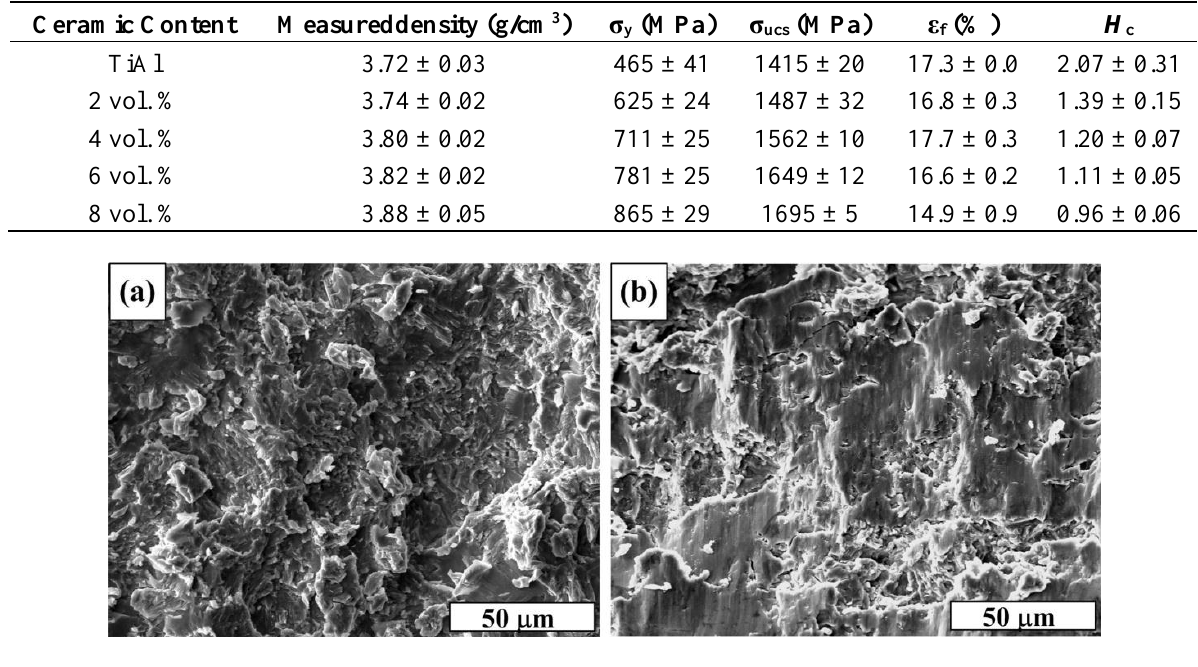
Figure 4. SEM images of the compression fractured surfaces of ( a ) 6 vol. % and ( b ) 8 vol.